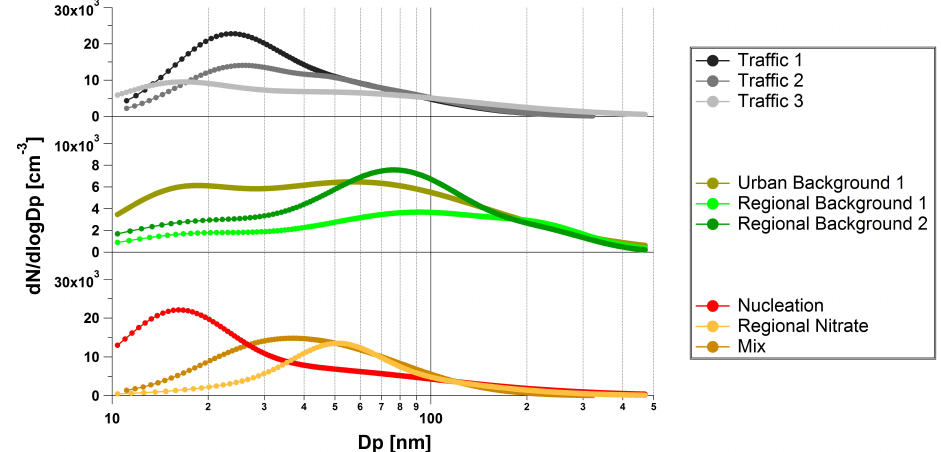
Fig. 1. Aerosol size-resolved distributions of the nine clusters’ results from the k -means analysis performed on the SMPS data at all SAPUSS monitoring sites. Table 2. Summary of the lognormal fitting of the 9 clusters separated into the nucleation, Aitken and accumulation modes. Peak maximum values were found between 15 and 24nm for the nucleation mode, 33–77nm for the Aitken mode and particles larger than 100nm correspond to the accumulation mode. The total area percentage for each peak is also indicated. Type k -means cluster nucleation